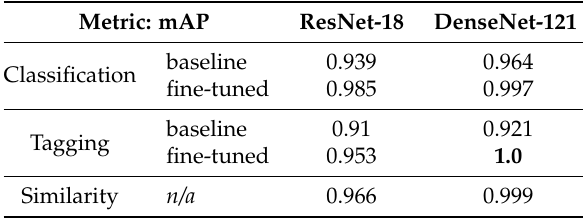
Table 4. A comparison of the performance of various models measured on the queries of TestSet50. All models were used in a similarity matching setting, with Classification and Tagging models used either with (fine-tuned) or without further training (baseline). For both Classification and Tagging tasks, the models were modified by removal of the final layer in order to use the activations of the penultimate layer as an embedding in a high-dimensional